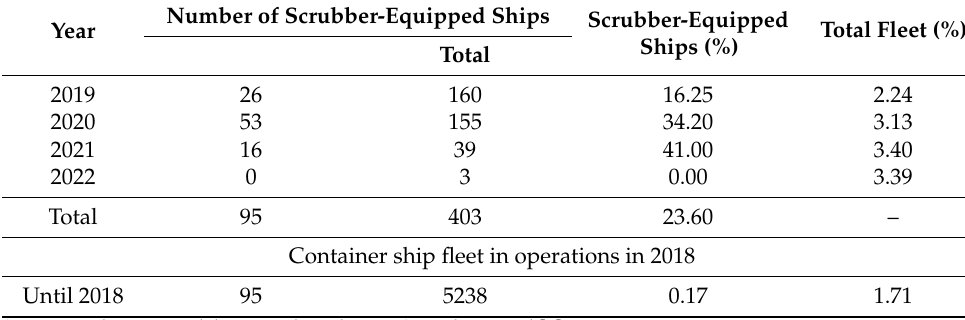
Table 6. Ordered container ships to be delivered in